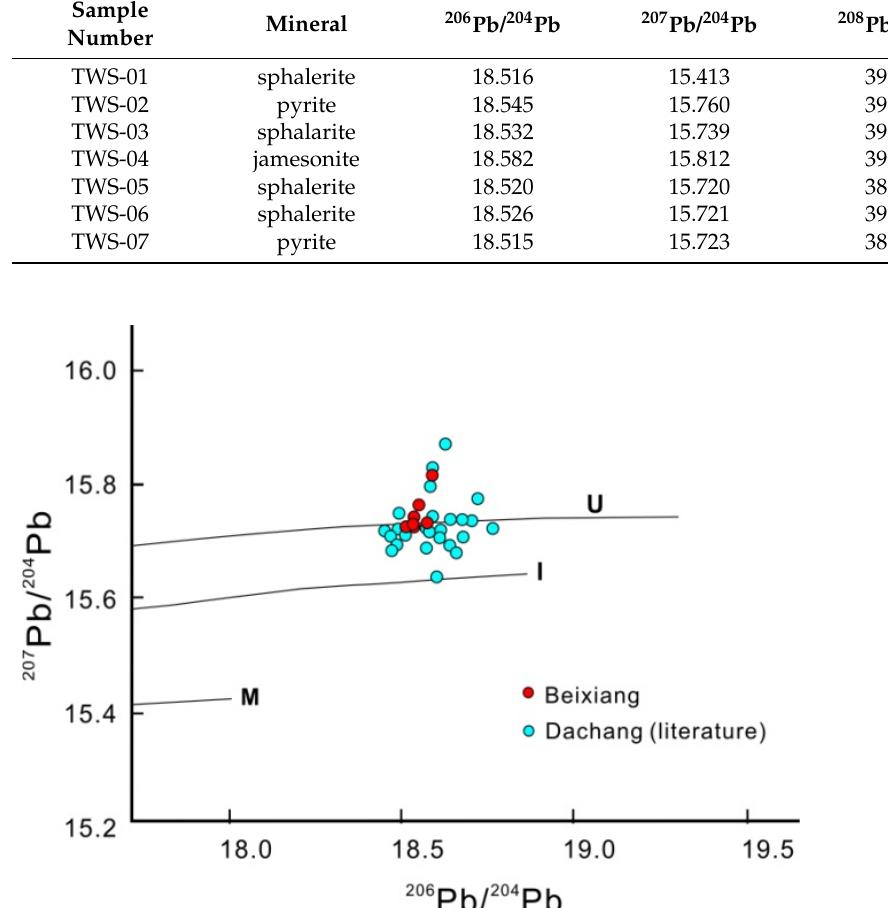
Figure 6. 206 Pb/ 204 Pb vs. 207 Pb/ 204 Pb plot of the Beixiang deposit. Plumbotectonic framework trends are plotted for reference (U: upper crust, I: orogen, M: mantle [34]). Table 4. Pb isotopic compositions of the Beixiang deposit.